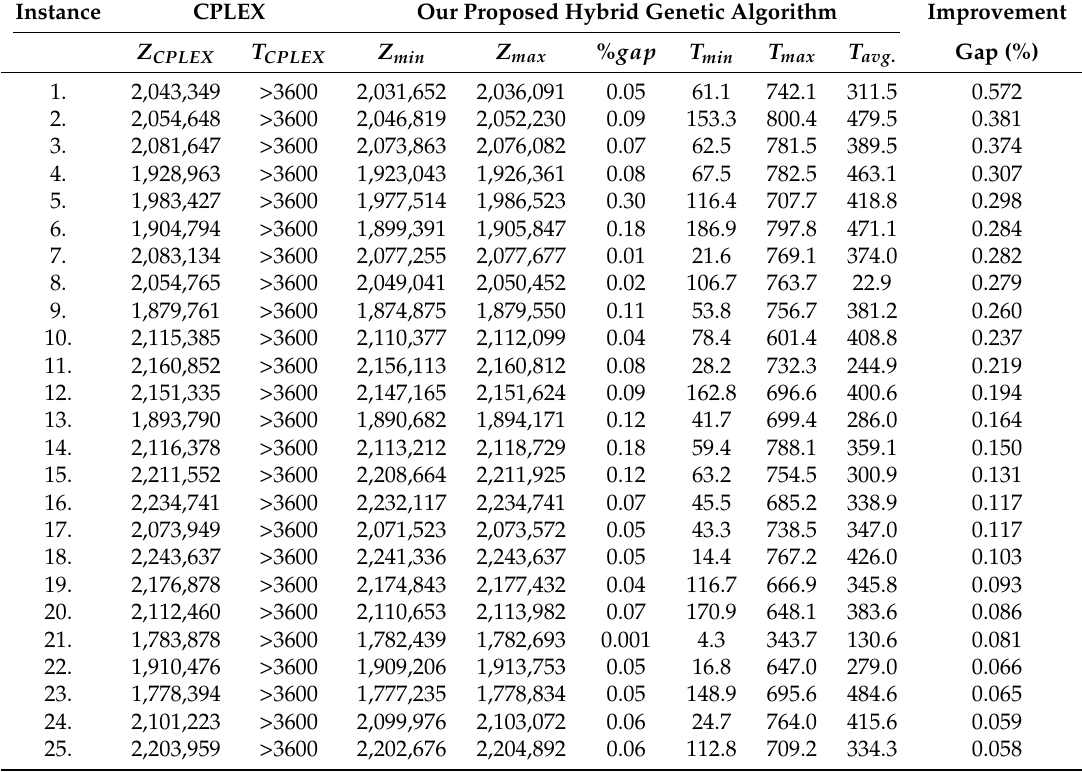
Table 5. Computational results achieved in the case of larger sized instances